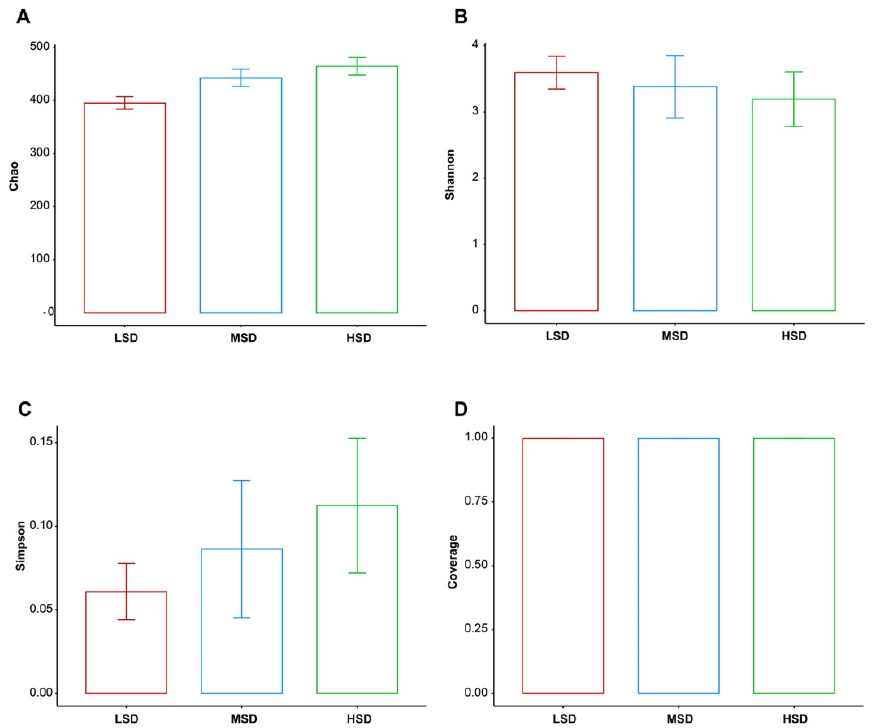
Figure 3. Diversity of the bacterial communities. ( A ) Chao estimator (Chao). ( B ) Shannon diversity index (Shannon). ( C ) Simpson diversity index (Simpson). ( D ) Coverage diversity index (Coverage). Date presented as mean ±